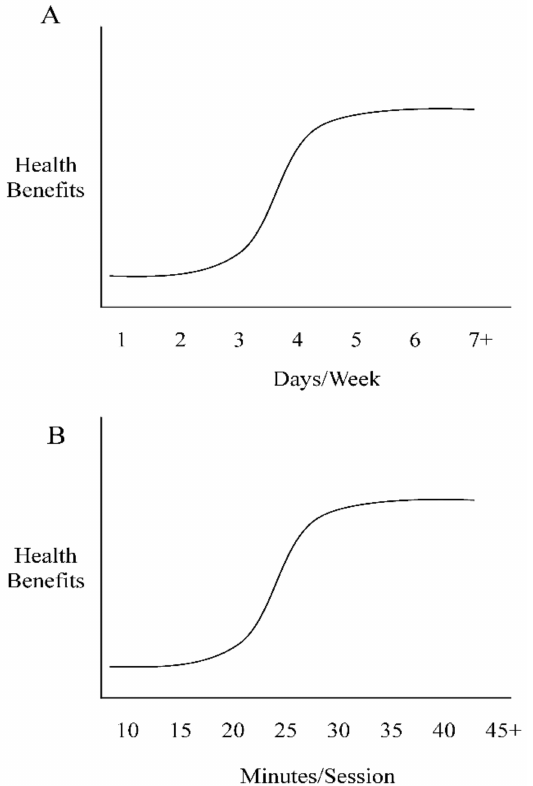
Figure 2. ( A ): Frequency dose-dependent responses to sauna bathing; ( B ): time dose-dependent responses to sauna